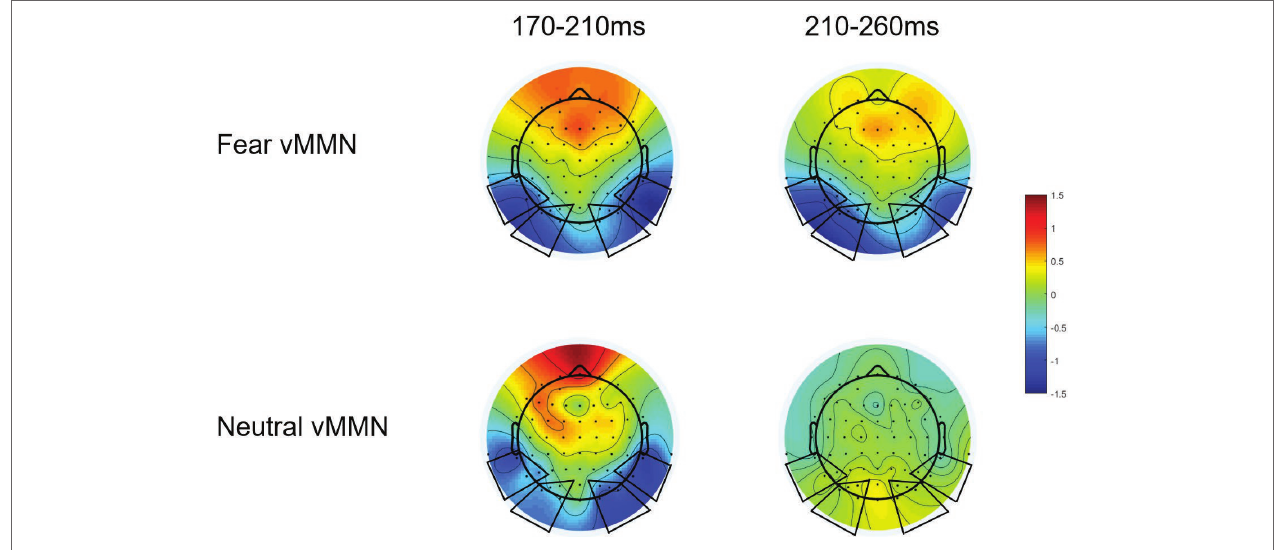
FIGURE 2 | Scalp topographic maps of vMMN (EMMN) components evoked by devFear and